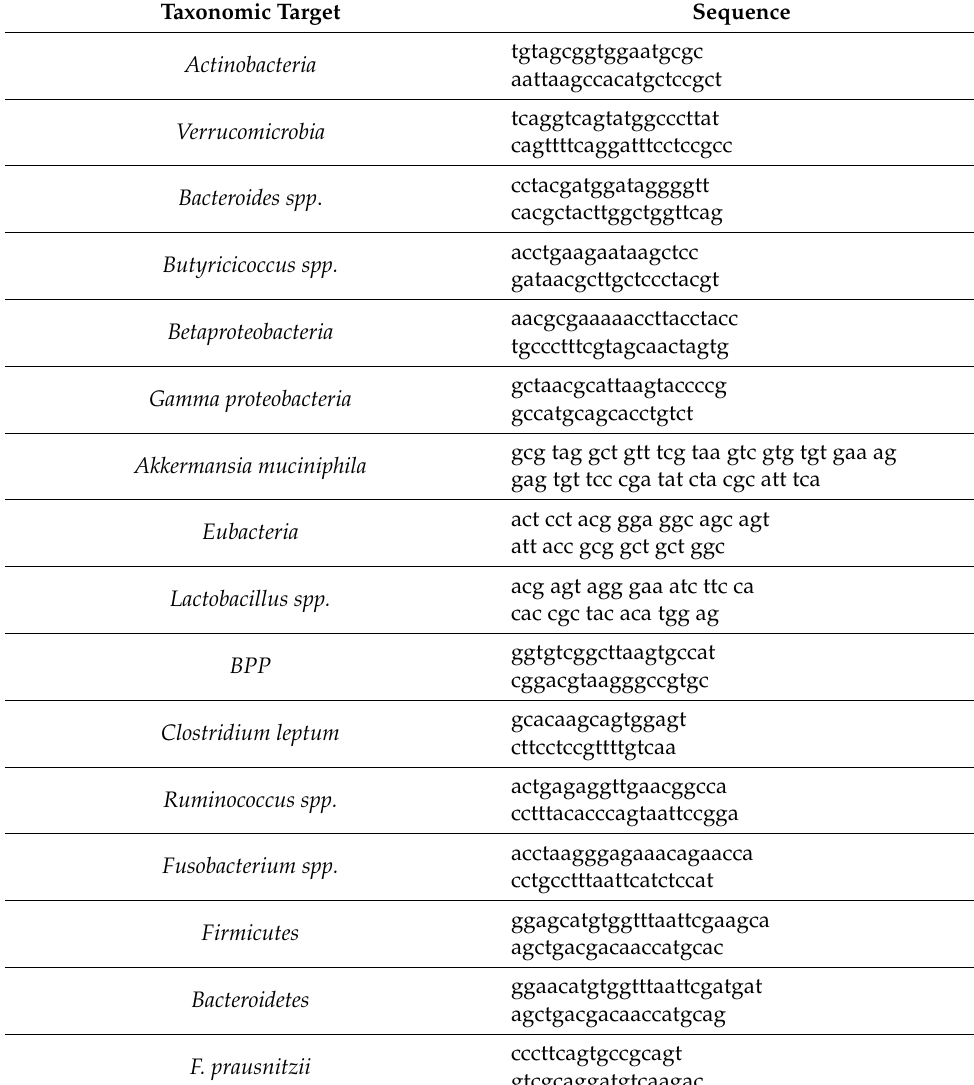
Table 2. The sequences of the primers